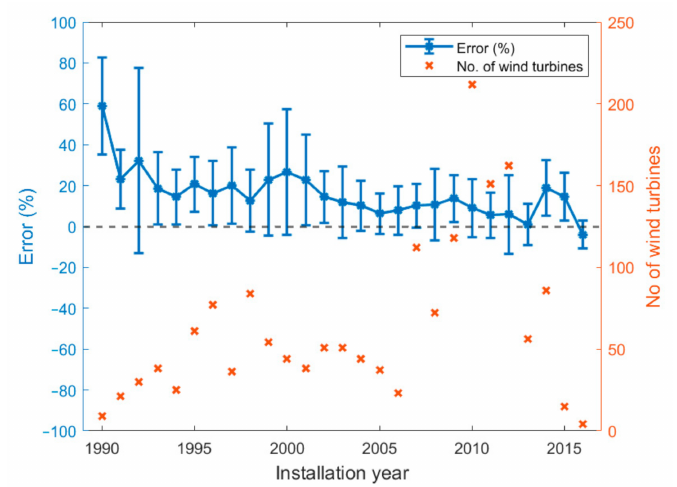
Figure 4. Error of AEP predictions depending on the installation year plotted with the standard deviation (blue) and number of wind turbines (red).